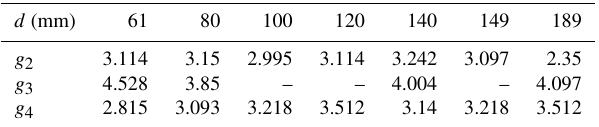
Figure 10. Test case d = 189mm. Lab-measured data (red) and nu- merically computed time series at wave gauge g 4 using different numerical models.